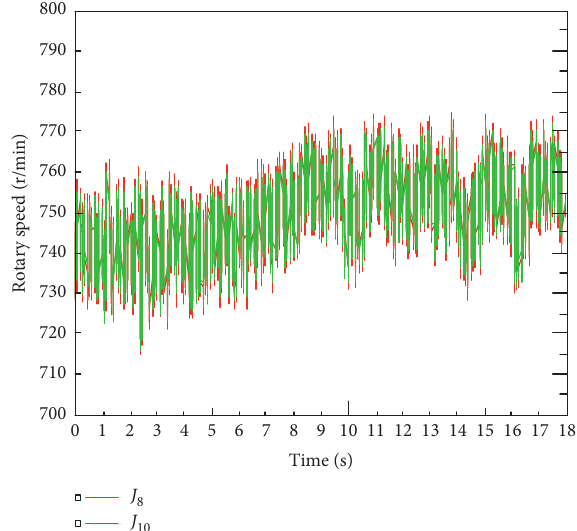
Figure 27: The overall angular acceleration curves of the primary flywheel and the input shaft of the gearbox matching the DMF under the idling condition.